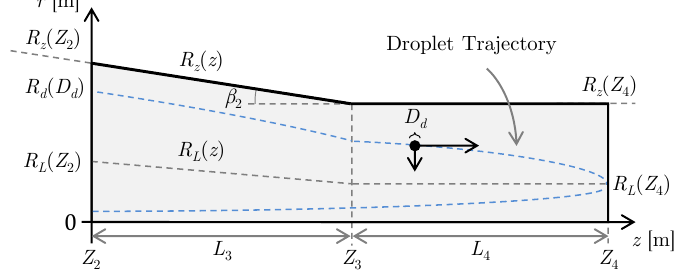
Figure 12. Upper half cross-section of S 3 and S 4 with critical trajectory for droplet with diameter D d in ( r , z )